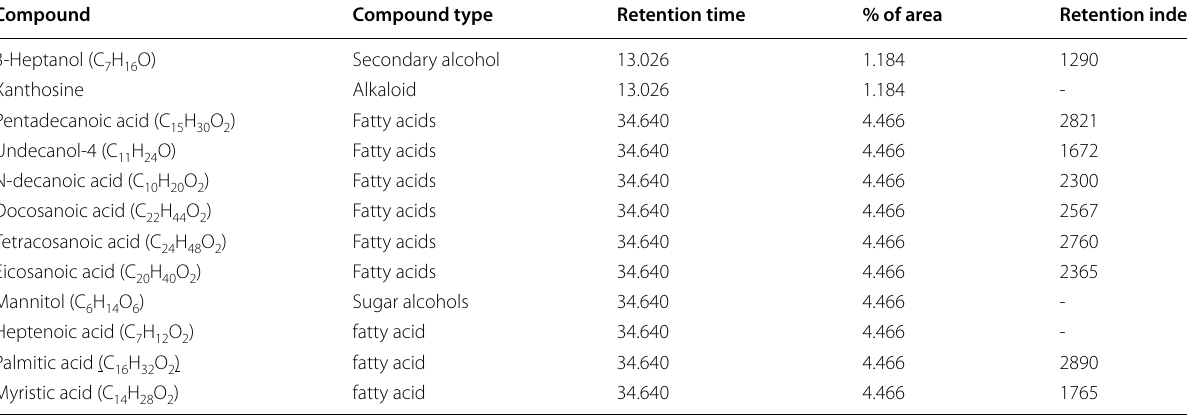
Table 9 Characterization of metabolite screening through GC–MS analysis in P. dendritica